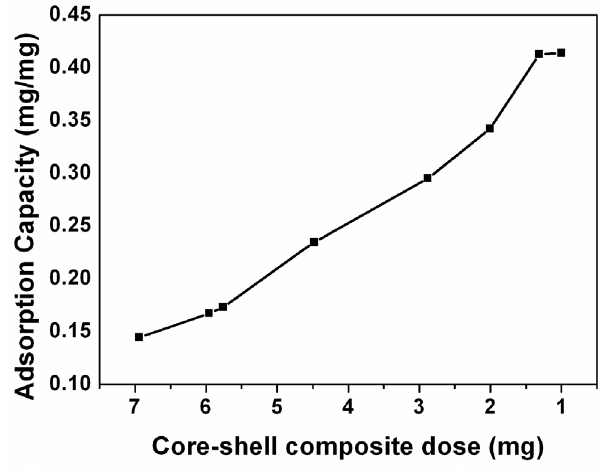
Figure 6. Adsorption capability of silica/cobalt hydroxide